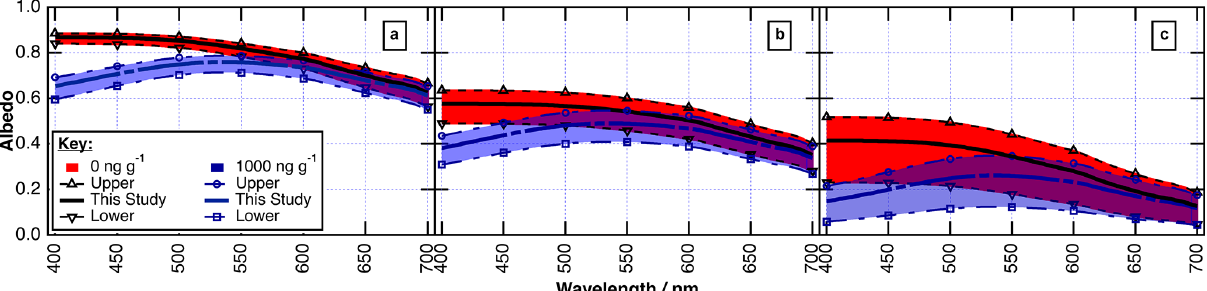
Figure 8. Wavelength-dependent albedo of multi-year (a) , first-year (b) , and melting sea ice (c) . Shown here is the variability in the albedo of each type of sea ice based on scattering cross-sections described in the literature (Grenfell and Maykut, 1977; Perovich, 1990, 1996; Timco and Frederking, 1996; Gerland et al., 1999; Simpson et al., 2002; Fisher et al., 2005; King et al., 2005; France et al., 2011; Marks and King, 2013), ranging from 0.5–1m 2 kg − 1 for multi-year sea ice, 0.1–0.2m 2 kg − 1 for first-year sea ice, and 0.01–0.05m 2 kg − 1 for melting sea ice. Shown in red are the data with no oil pollution present, and shown in blue are the data with 1000ngg − 1 of Romashkino oil present. The thicker lines show the values of typical ice that are used in this study. The melting sea ice and multi-year sea ice are 2.5m thick; the first-year sea ice is 0.8m thick; and the background concentration of black carbon is set to 5.5ngg − 1